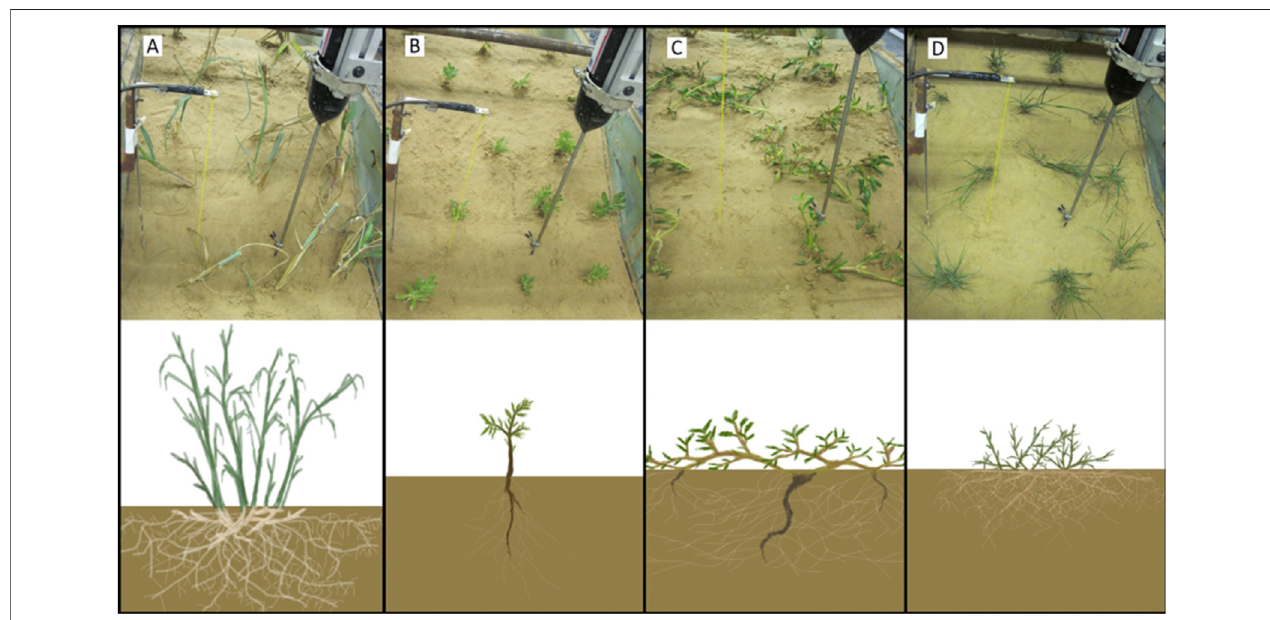
FIGURE 1 | Photos (top panels) and schematics (bottom panels) of plants used in sediment wave fl ume experiment. Four species/morphotypes of plants were used for this experiment: A tall grass ( A : P. amarum ), a small forb ( B : R. phyllocephala ), a spreading vine ( C : S. portulacastrum ), and a short grass ( D : S. virginicus ). Photos depict initial dune pro fi le conditions for vegetated trials using 3-week-old transplants. Schematics highlight differences in above- and below-ground structure of the four different plant